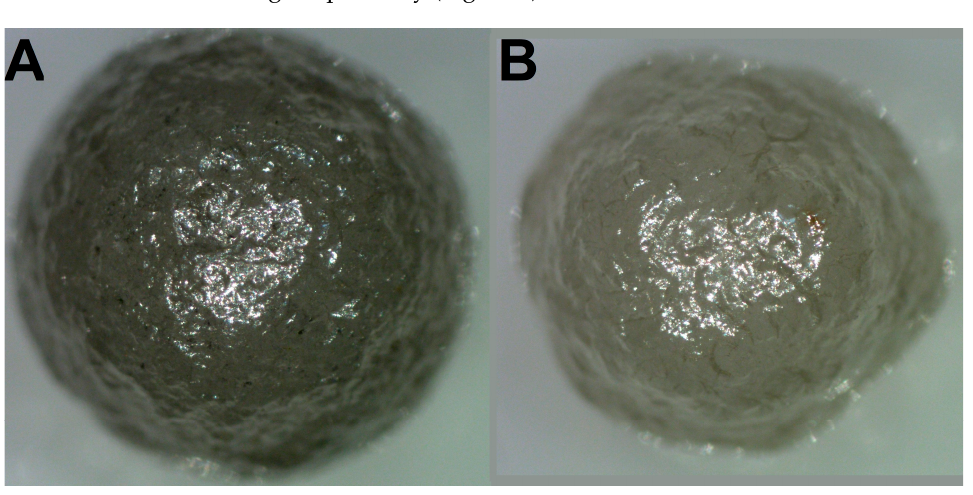
Figure 1. Optical images of the studied samples. ( A )—“large” ballas, ( B )—“small”. The diameter of the “large” specimen is 4 mm, and the “small” one is 3.5 mm.